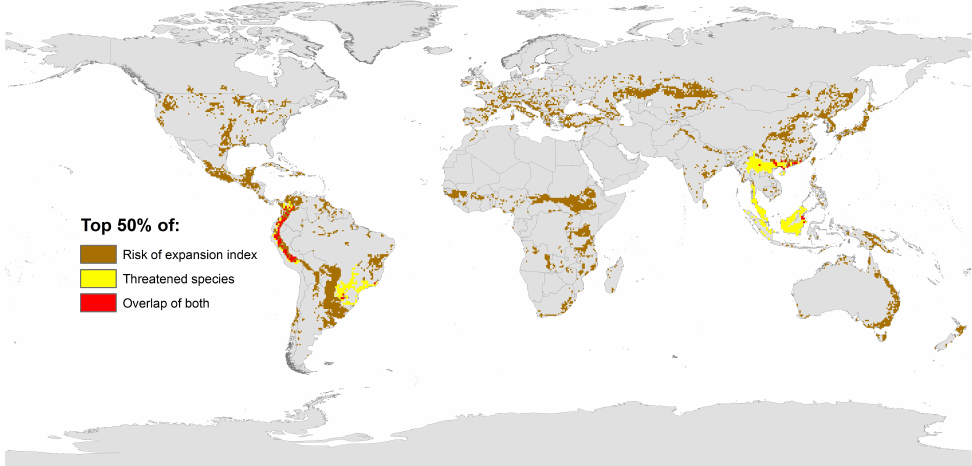
Figure 5. Overlay of threatened species richness and risk of expansion index.